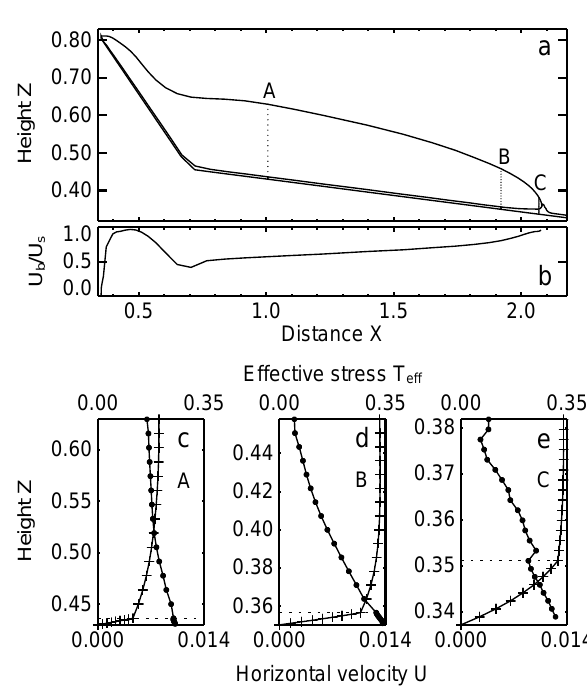
Fig. 10. Experiment B: Relatively soft and moderately non-linear till ( m =3 , B =0 . 35 ): (c–e) vertical profiles of the non-dimensional horizontal velocity U (lines with crosses) and effective stress T eff (lines with dots) are shown at a dimensionless time T = 15 for the three locations A, B and C shown in (a) . Note that the vertical scale changes for each profile. (b) shows the ratio between the horizontal velocity at the ice-sediment interface U b to the one at the glacier surface U s .